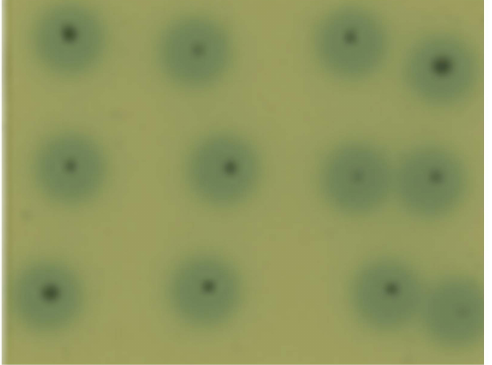
Figure 2. Image of the RF used to verify the position of the dosimeters in the radiation field.